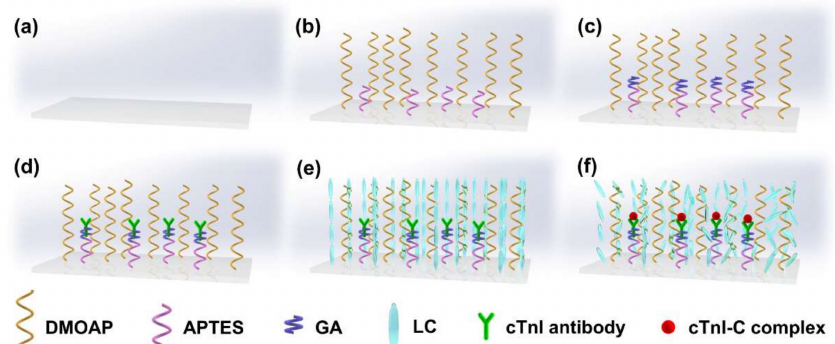
Figure 3. Schematic illustration of the inner wall functionalization and detection strategy of the HGMS. ( a ) bare inner wall; ( b ) silanization; ( c ) aldehyde modification; ( d ) antibody incubation; ( e ) LC modification; ( f ) antigen capture.